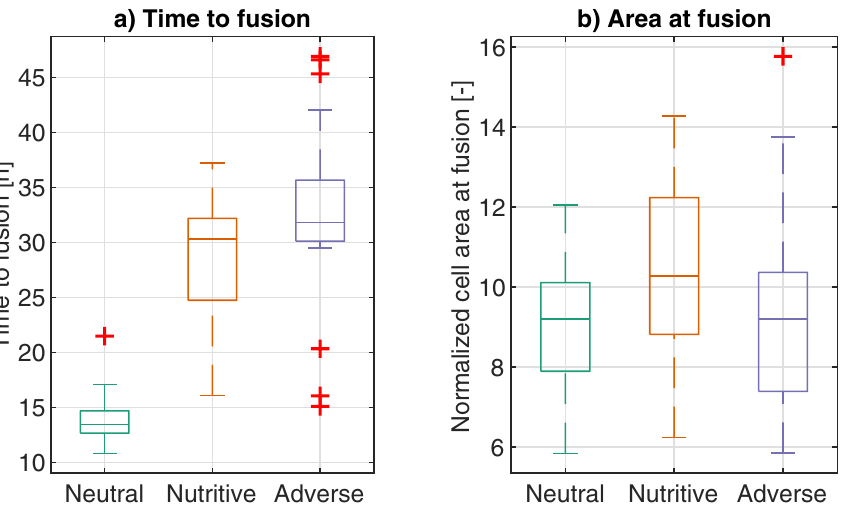
Figure 15. Time to fusion. ( a ) Boxplot with distribution of time elapsed from the beginning of the experiment until fusion between slime molds occurred. ( b ) Distribution of normalized areas (relative to initial cell area) of the slime mold cells at the time of fusion. Box plots show median (horizontal line), interquartile range (box), distance from upper and lower quartiles times 1.5 interquartile range (whiskers), and outliers ( > 1.5 x upper or lower quartile).